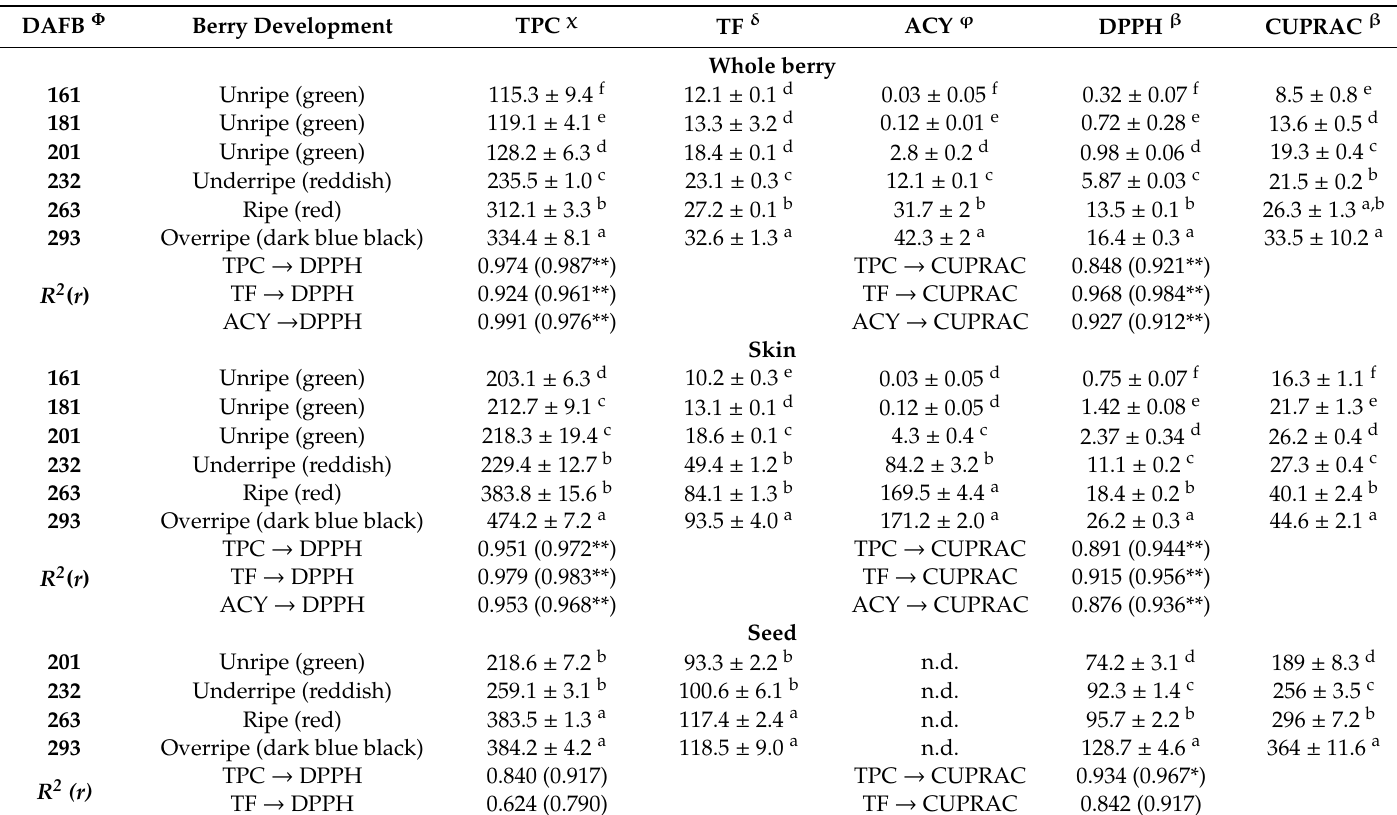
Table 1. Phenolic compounds contents (TPC, TF and ACY) and antioxidant capacity values (DPPH and CUPRAC) in berries of black ‘Isabel’ grape during berry